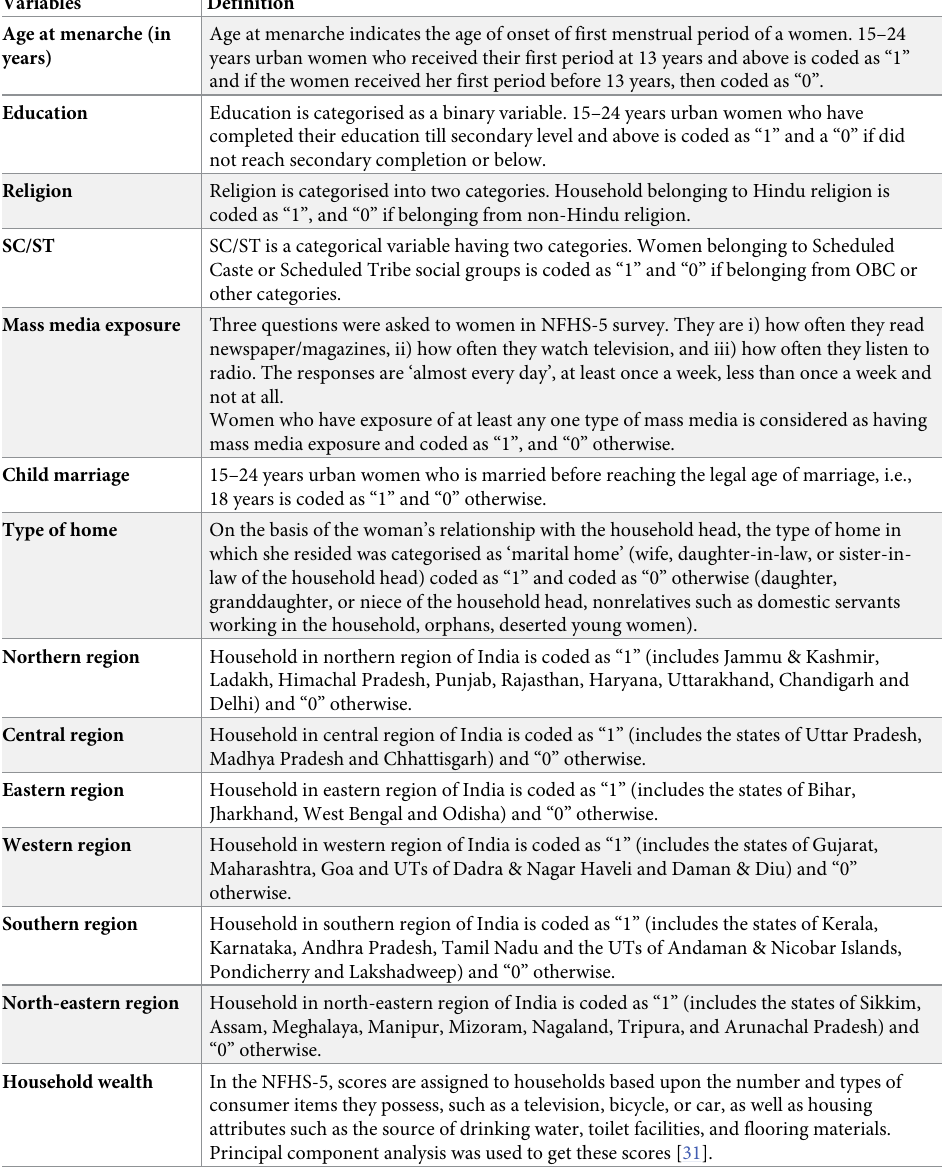
Table 1. Operational definition of